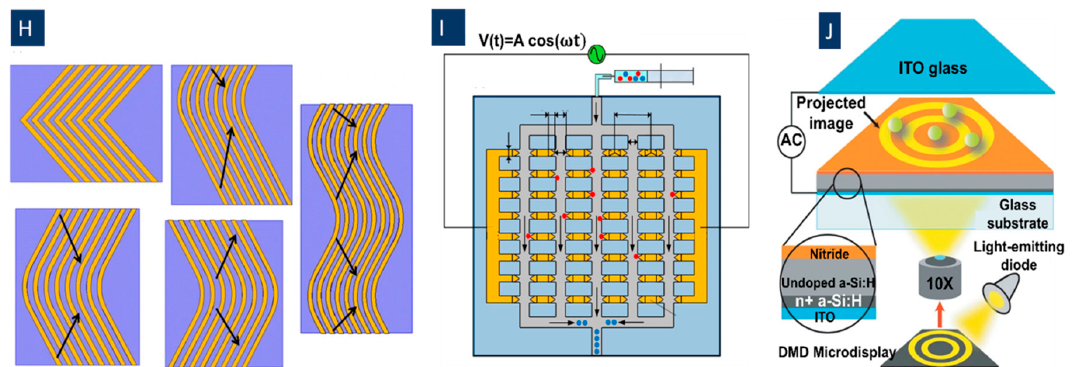
Figure 2. A variety of electrode configurations used in DEP applications. ( A ) Simple planar inter- digitated electrodes; ( B ) planar trapezoidal electrodes; ( C ) planar slanted interdigitated electrode arrays; ( D ) spiral electrodes are used in travelling-wave DEP to produce an electric field phase gradient (Reprinted with permission from [78]. Copyright 2009, Springer); ( E ) side-wall electrodes for having a uniform electric field in the direction of the channel height (Reprinted with permission from [58]. Copyright 2020, Multidisciplinary Digital Publishing Institute (MDPI)); ( F ) 3D electrode geometry created by Co-fabrication of adjoining electrodes and channels (Reprinted with permission from [53]); ( G ) 3D conducting PDMS composites are generated by mixing silver powders with PDMS gel (Reprinted with permission from [62]); ( H ) different chevron electrode structures to eliminate the irregular electric field and unpredictable DEP and twDEP behaviors of the cells. (a) Simple chevron electrodes. (b) Chevron electrodes after removing the sharp angle. (c) Transferring the curve of the electrodes to a side instead of the center. (d) The reverse boomerang-shaped electrodes. (e) Wave- shaped electrodes (Reprinted with permission from [76]. Copyright 2015, Springer); ( I ) Floating electrode arrays eliminate the need for external ohmic connection to individual array units(Reprinted with permission from [77]. Copyright 2018, American Institute of Physics (AIP) Publishing); ( J ) Opti- cal DEP to form any shape of electrodes on -the photoconductive surface (Reprinted with permission from [79]. Copyright 2005, Springer